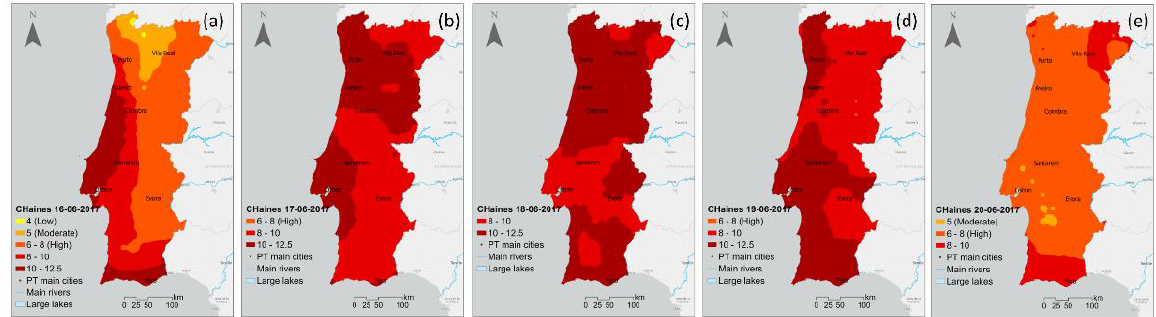
Figure 8. Daily mean values for ( a ) 16, ( b ) 17, ( c ) 18, ( d ) 19, and ( e ) 20 June 2017, for CHI.